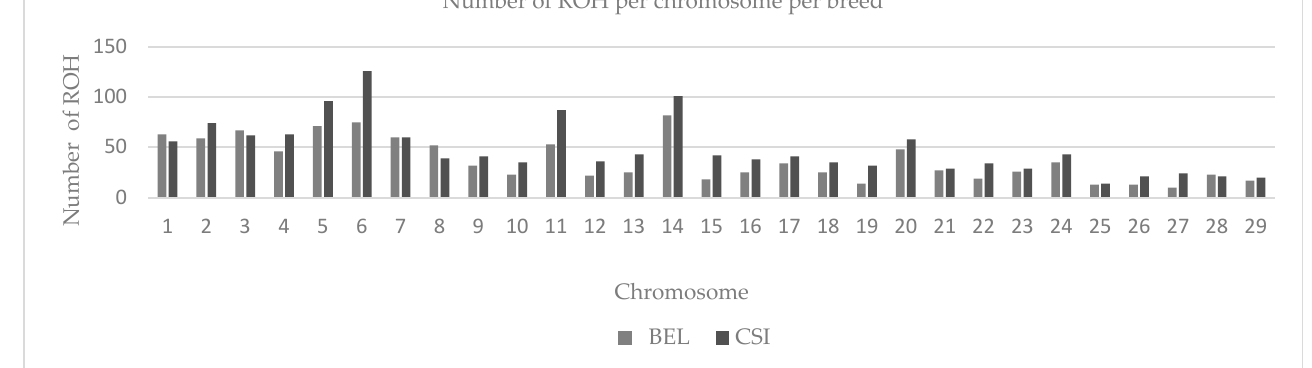
Figure 2. Number of ROH per chromosomes for Chinese CSI and BEL with significant ROH observed on chromosomes 5, 6, 11, and 14 for both breeds.